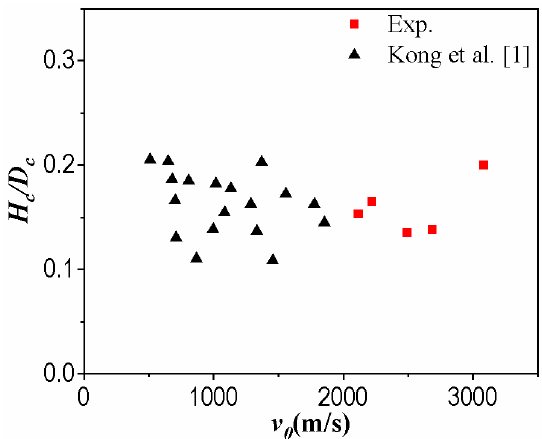
Figure 16. Influence of the impact velocity on the ratio of crater depth to diameter.